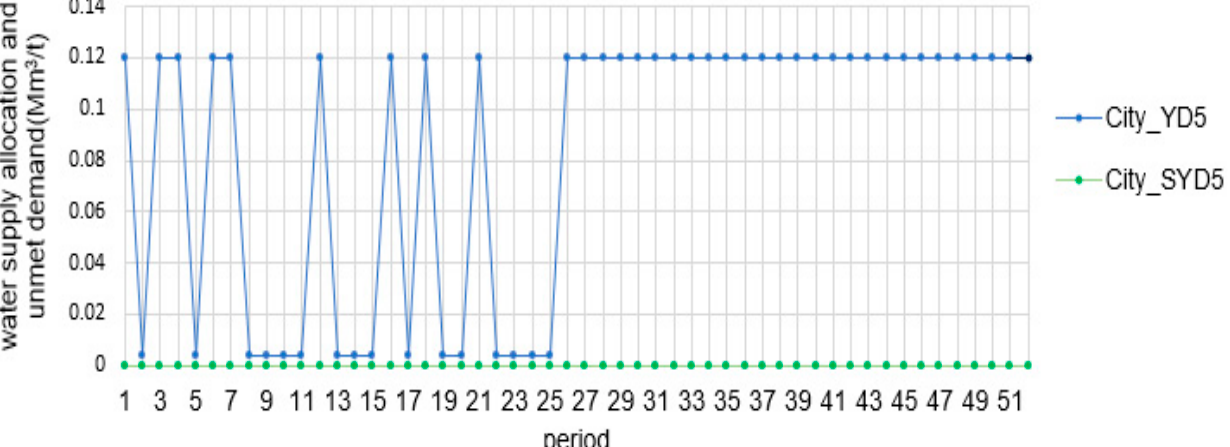
Figure 27. Water allocation and unmet demand flow for Sokoru & Deneba towns’ municipal water supply (Mm 3 /week).